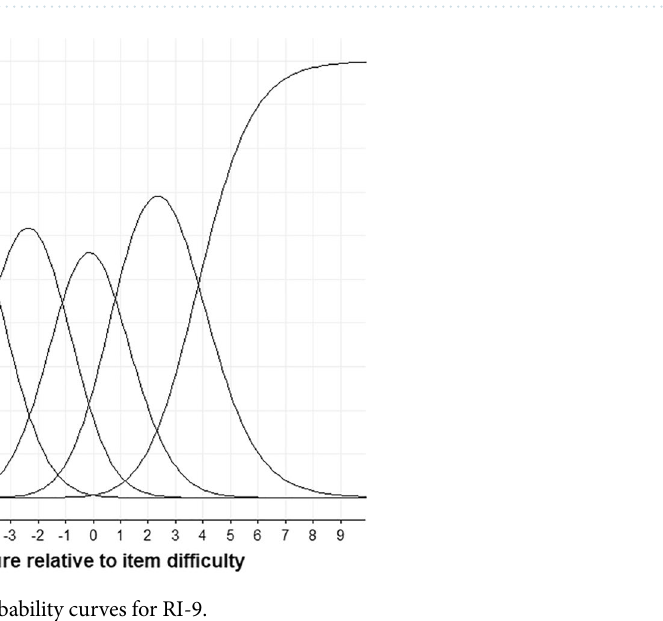
Figure 1. Person-item Wright Map of RI-9. Legend: Histogram representing person distribution, more able persons with high level of resilience are located at the top of the map. More difficult (strong resilience) items are located at the top of the map, X1 = Male group, X2 = Female group, Circles are item threshold, item 3 is the easiest item; item 5 is the hardest. The mean of the items is much lower than the person’s ability, indicating that RI-9 is relatively easy for this sample.